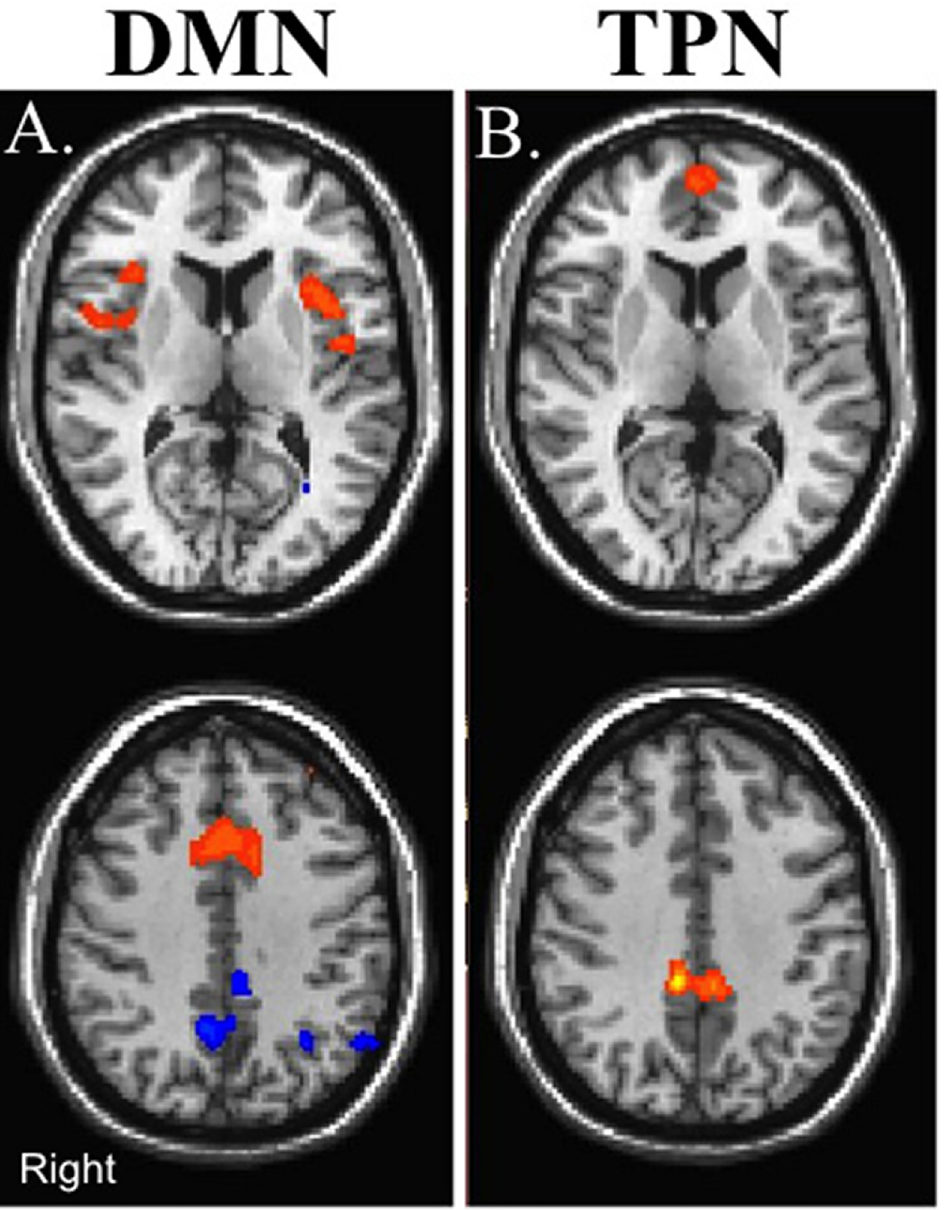
Fig 3. Between group contrast maps for control participants versus mTBI group in the chronic stage. (A) DMN (B) TPN. Warm colors represent regions of increased rs-FC in the mTBI group and cool colors represent regions of reduced rs-FC in the mTBI group. Maps are thresholded at voxel wise p - value of 0.005 (uncorrected) and cluster extent threshold of p -value of 0.05 using a family wise error correction for multiple comparisons.